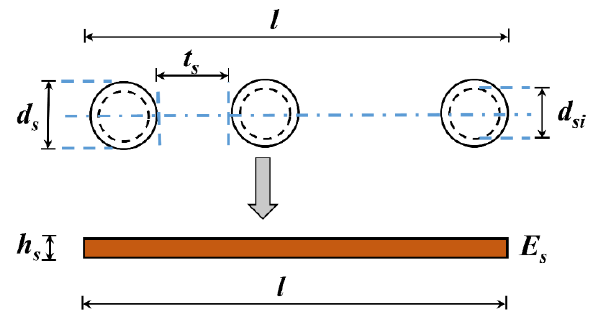
Figure 3. Equivalent of steel pipe piles.